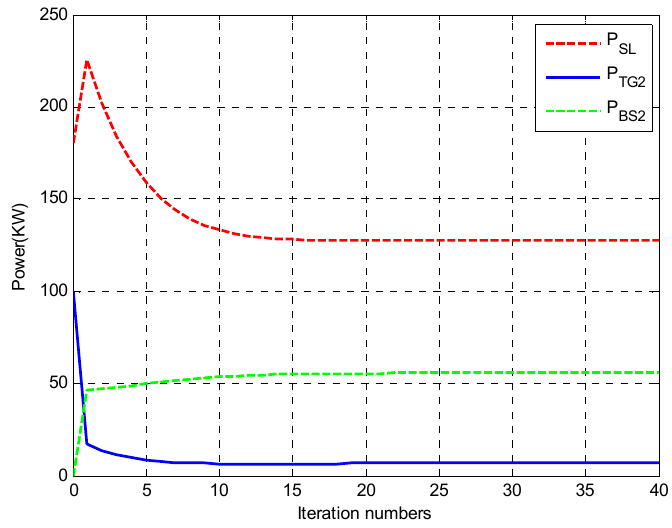
Figure 7. Power output of the DC side node of a single period in the DC sub-grid.